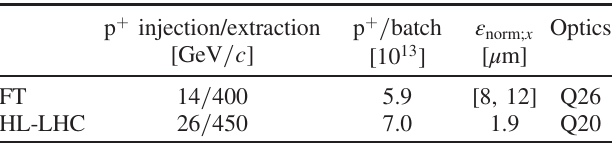
TABLE I. Comparison of some important parameters of FTand HL-LHC beams in the SPS.